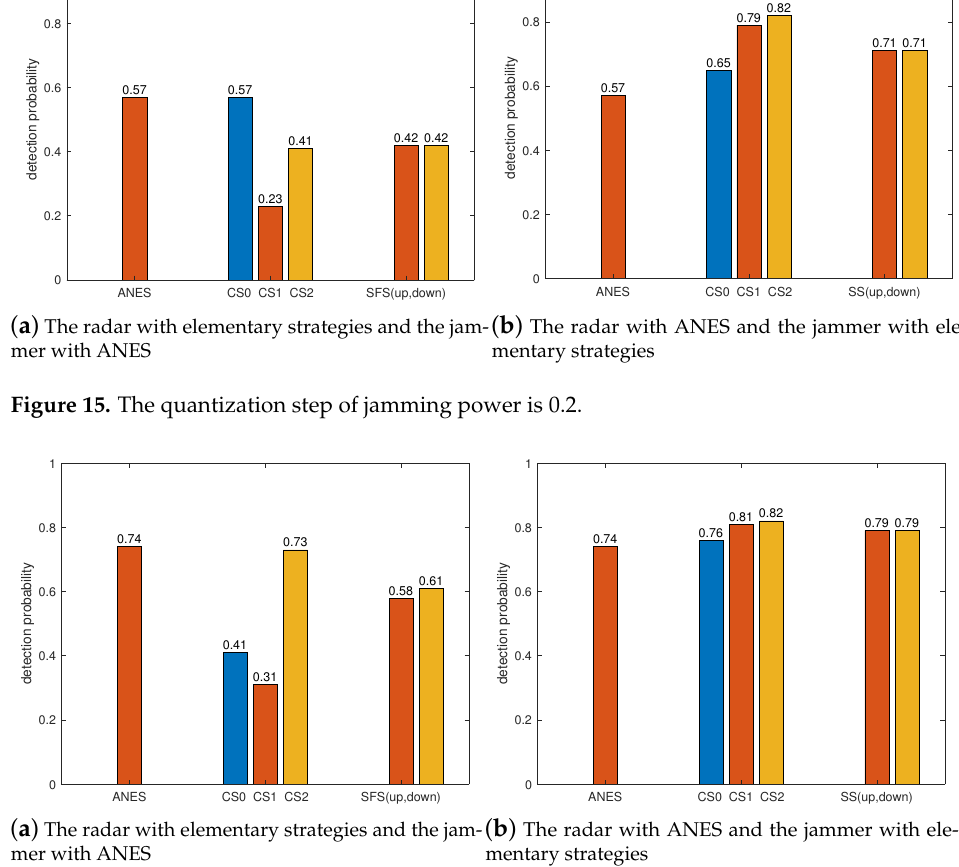
Figure 16. The quantization step of jamming power is